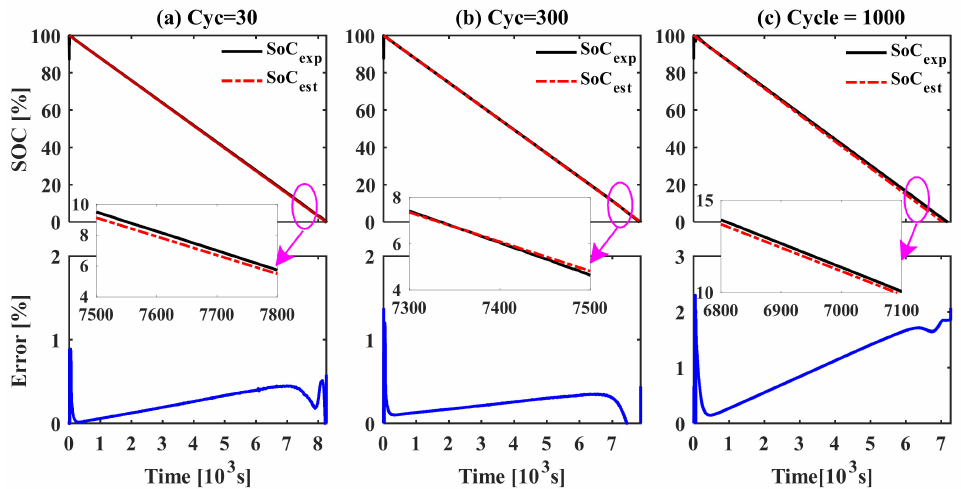
Figure 8. SoC estimation results and SoC errors at ( a ) Cyc = 30, ( b ) Cyc = 300 and ( c ) Cyc = 1000